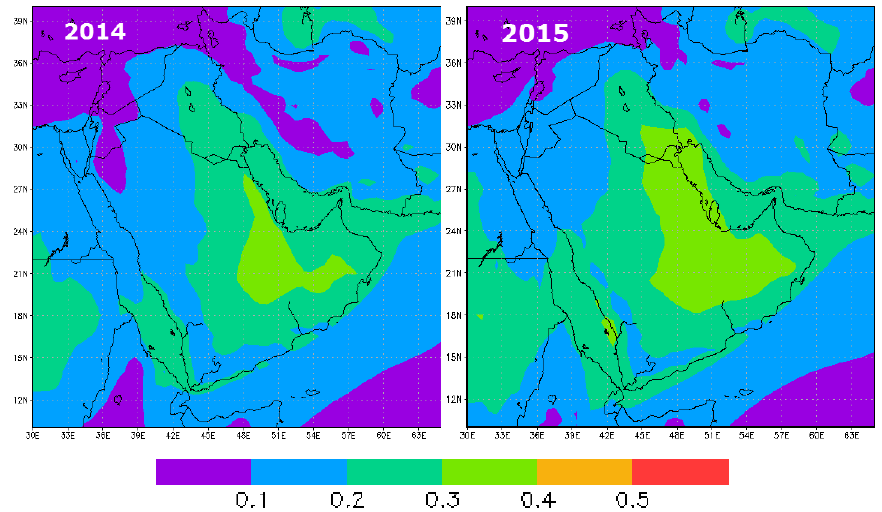
Figure 2. Inter-annual variation of dust AOT over the Arabian Peninsula from 2005 through